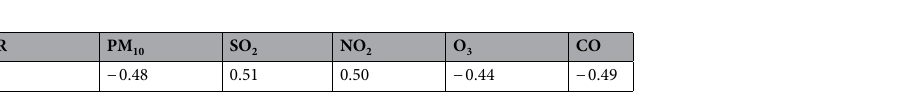
Table 5. Correlation between concentration of indicator pollutants and the number of monthly CD patients